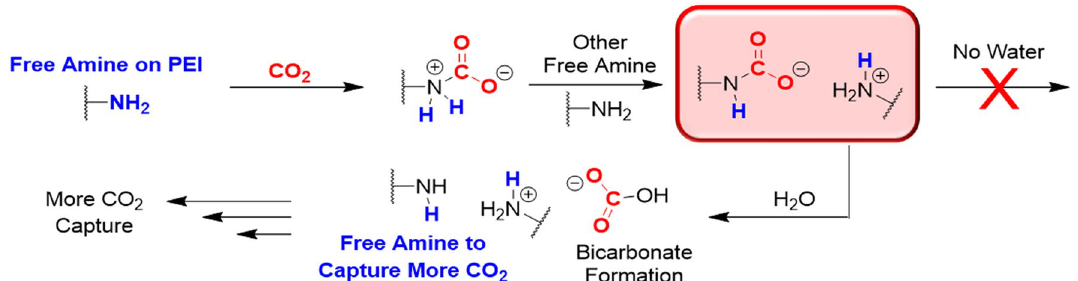
Figure 5. Proposed mechanisms of CO 2 capture by PEI with and without the prescence of water. The intermediate step indicated in red is the key step in this reaction process. Without the presence of water the reaction does not proceed and the amine does not become accessible. With the presence of water the reaction can proceed forward due to a free amine which can capture more CO 2